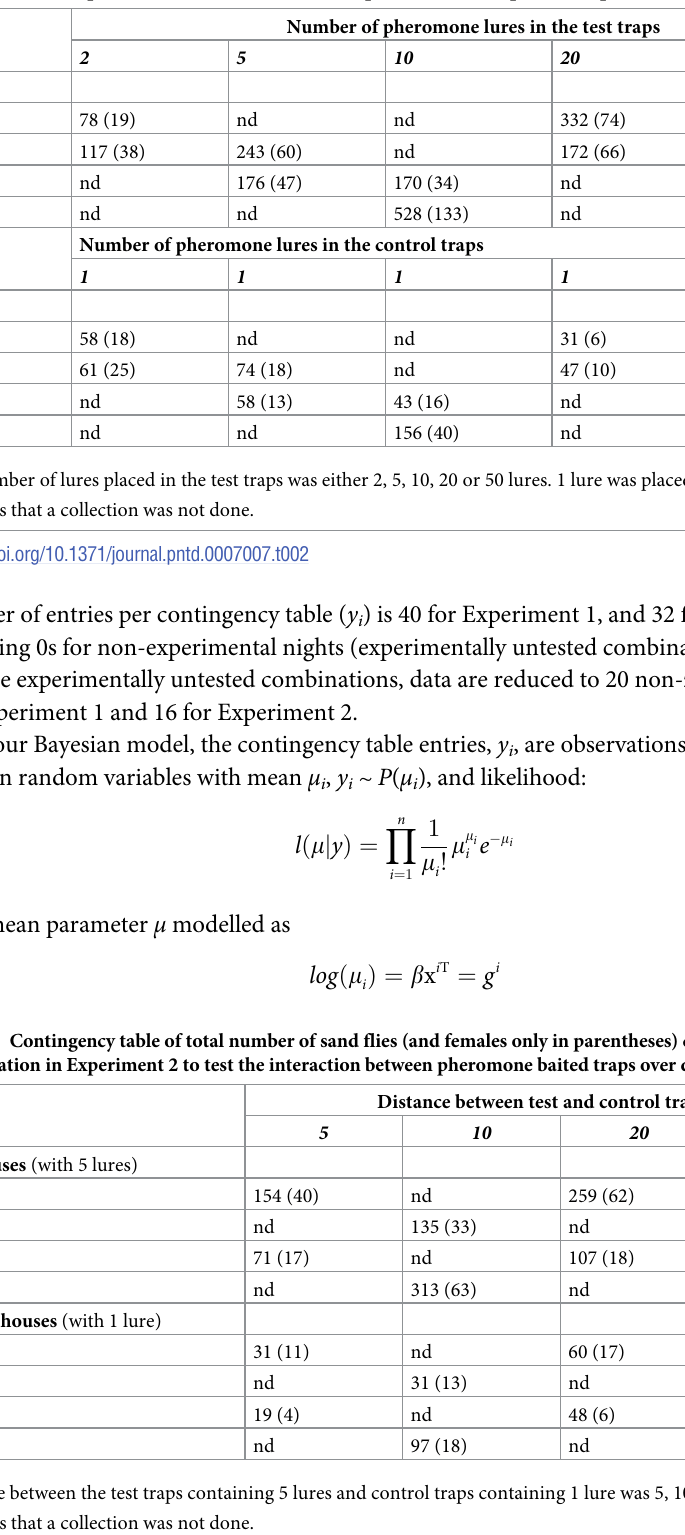
Table 2. Contingency table of total number of sand flies (and females only in parentheses) caught for each factor combination in Experiment 1, to test the number of pheromone lures per test trap. Number of pheromone lures in the test traps House